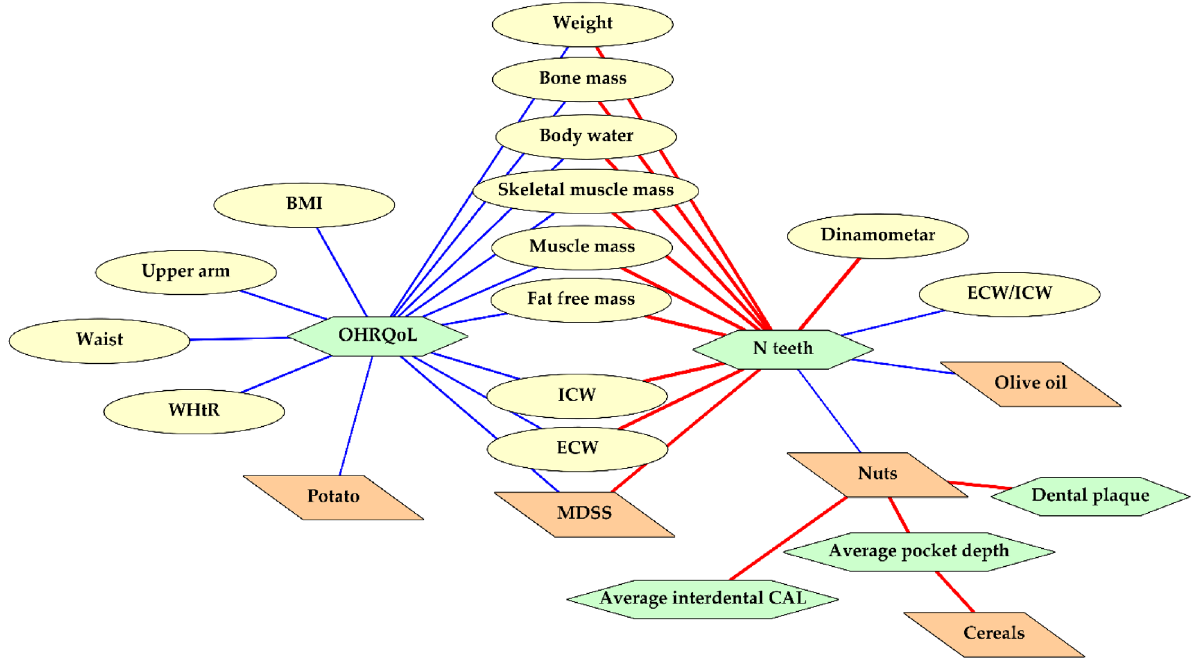
Figure 3. Significant associations between dental, MeDi and body composition parameters based on Spearman’s rank correlation. Abbreviations: BMI body mass index, WHtR waist-to-height ratio, ECW extracellular water, ICW intracellular water, MDSS Mediterranean Diet Serving Score, CAL clinical attachment loss; OHRQoL Oral Health Related Quality of Life. Color coding: yellow ellipses are body composition parameters; orange parallelograms are overall MeDi score and frequency of eating each MeDi component (frequency ranges from 1 to 7; 1—two or more times a day, 7—rarely or never); green hexagons are dental parameters; red lines represent significant positive correlation; blue lines represent the significant negative